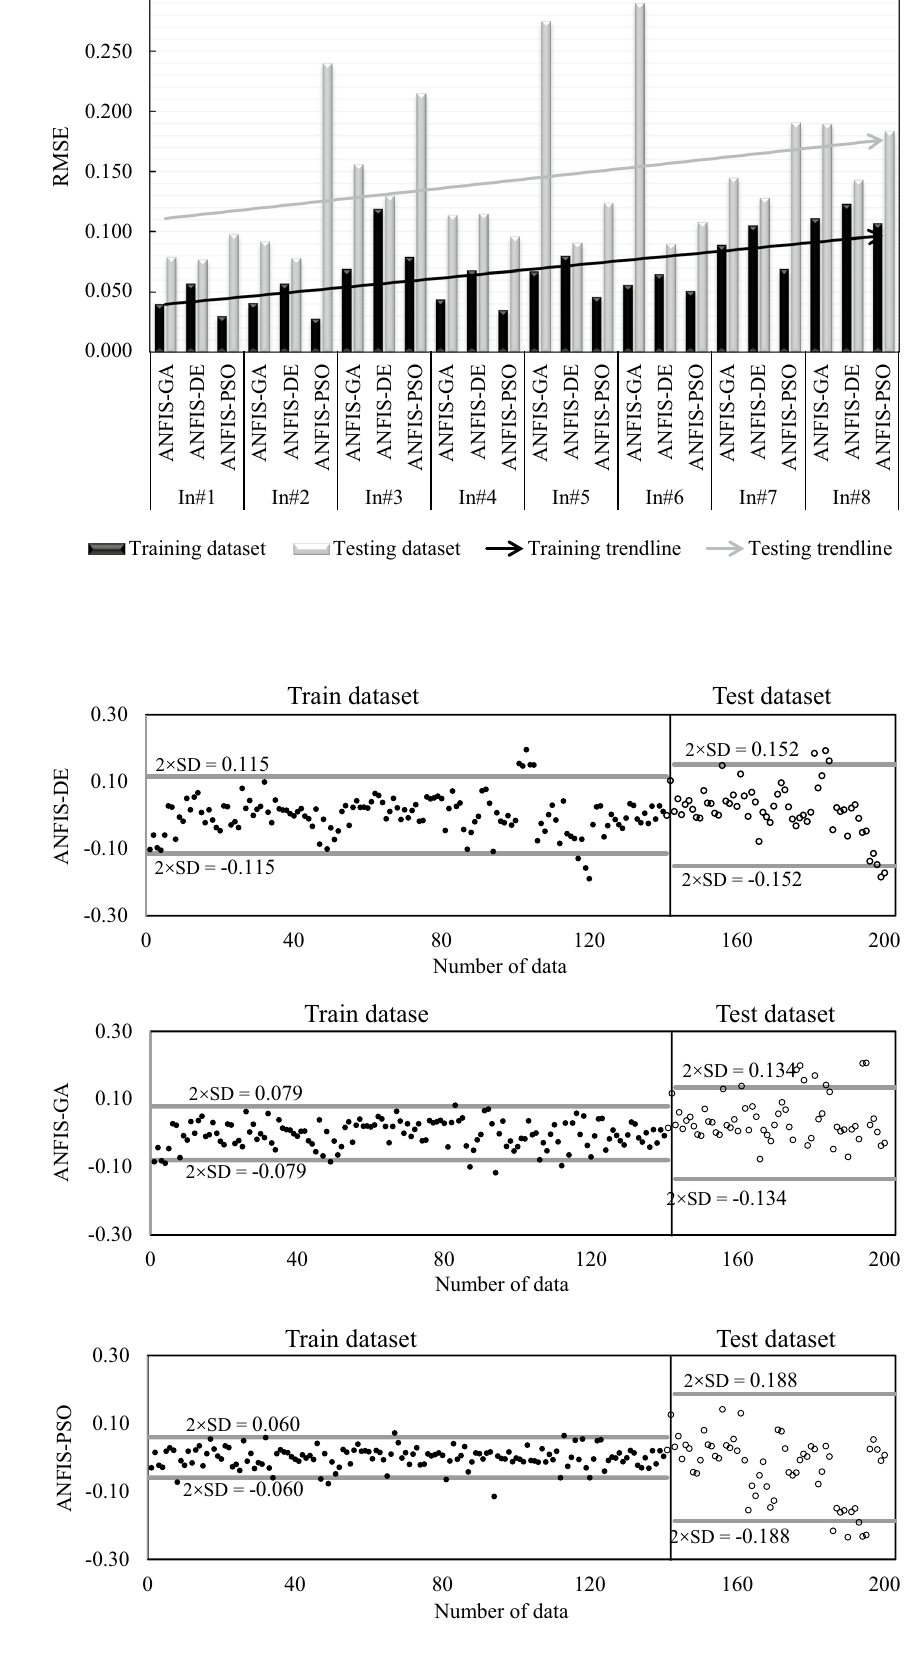
Fig. 10 Hybrid ANFIS meth- ods’ performance in the training and testing datasets